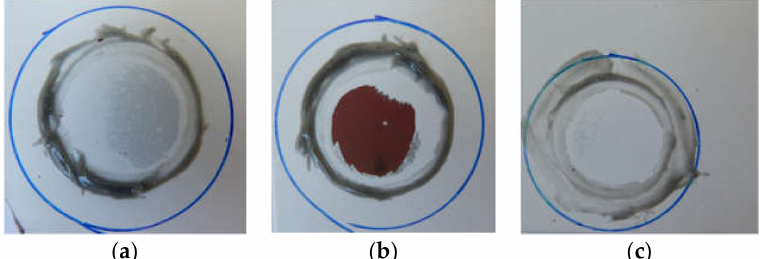
Figure 13. Appearance of the surface affected by the adhesion test area performed after the UV and humidity test, for ( a ) the sample with sand from Ouarzazate, ( b ) the sample with sand from Dubai, and ( c ) the sample without sand.